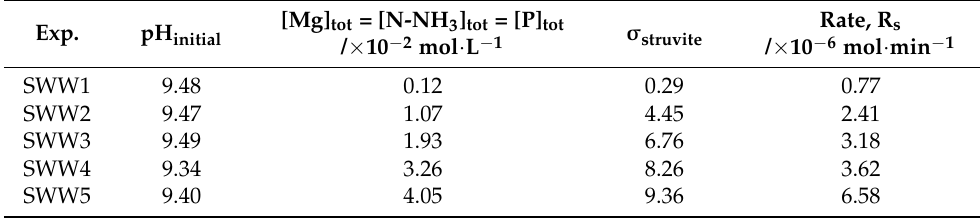
Table 4. Precipitation of struvite from synthetic wastewater supersaturated solutions. Initial pH value, magnesium concentration, Mg, relative supersaturation, σ and the corresponding rates measured for the experiments in synthetic wastewater (SWW) at 25 ◦ C.